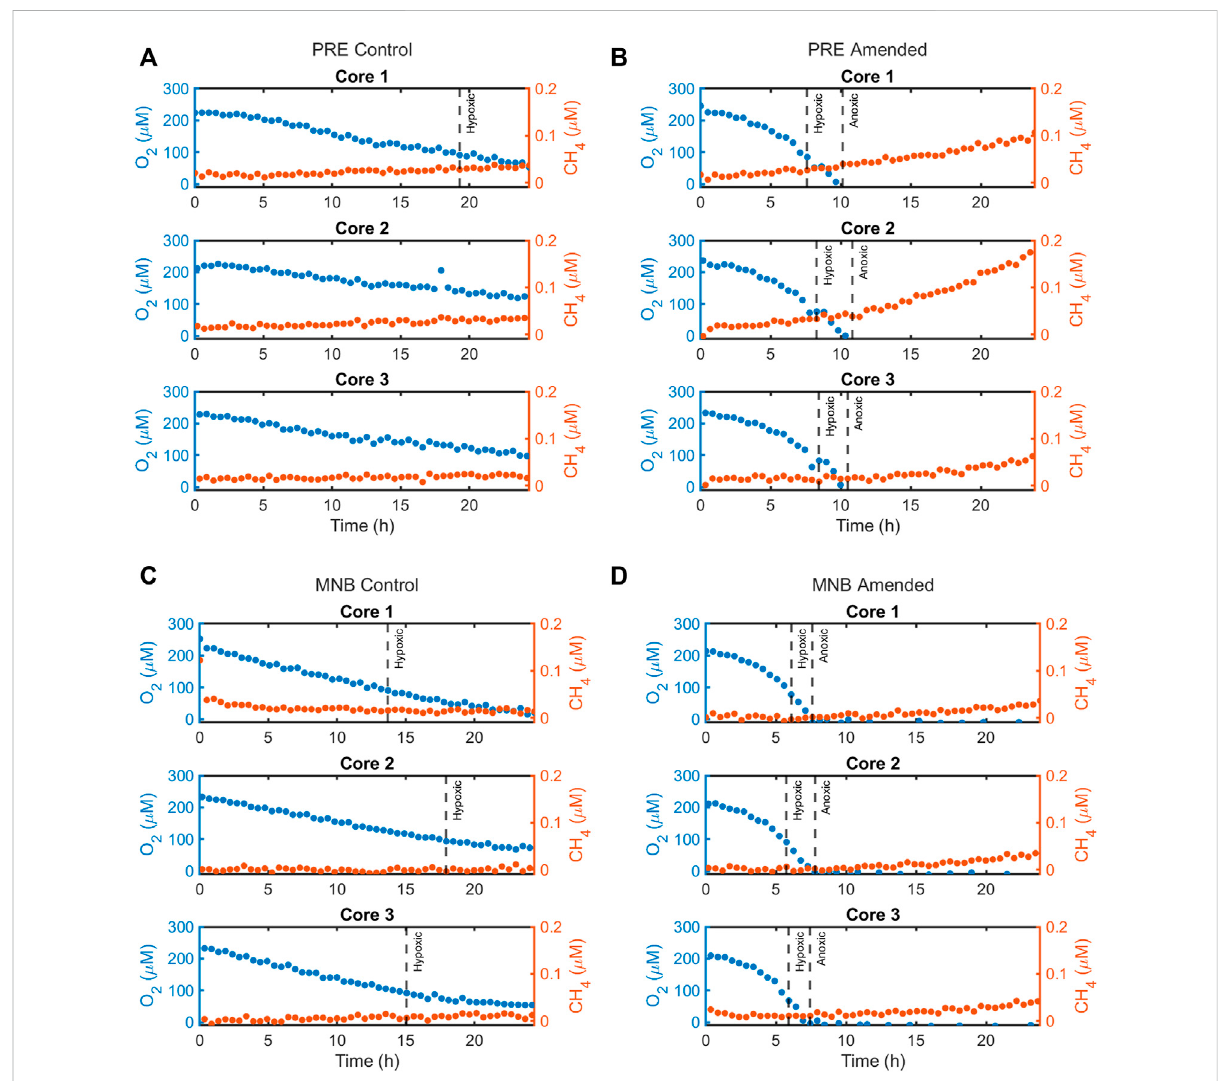
FIGURE 2 Calibrated concentration timeseries data for CH 4 (in red) compared to O 2 (blue), as measured by the fl ow-injection mass spectrometer system during the 24-h incubations for the four site and treatment combinations: (A) Providence River Estuary — Control treatment, (B) Providence River Estuary — Amended treatment, (C) Mid-Narragansett Bay — Control treatment, and (D) Mid-Narragansett Bay — Amended